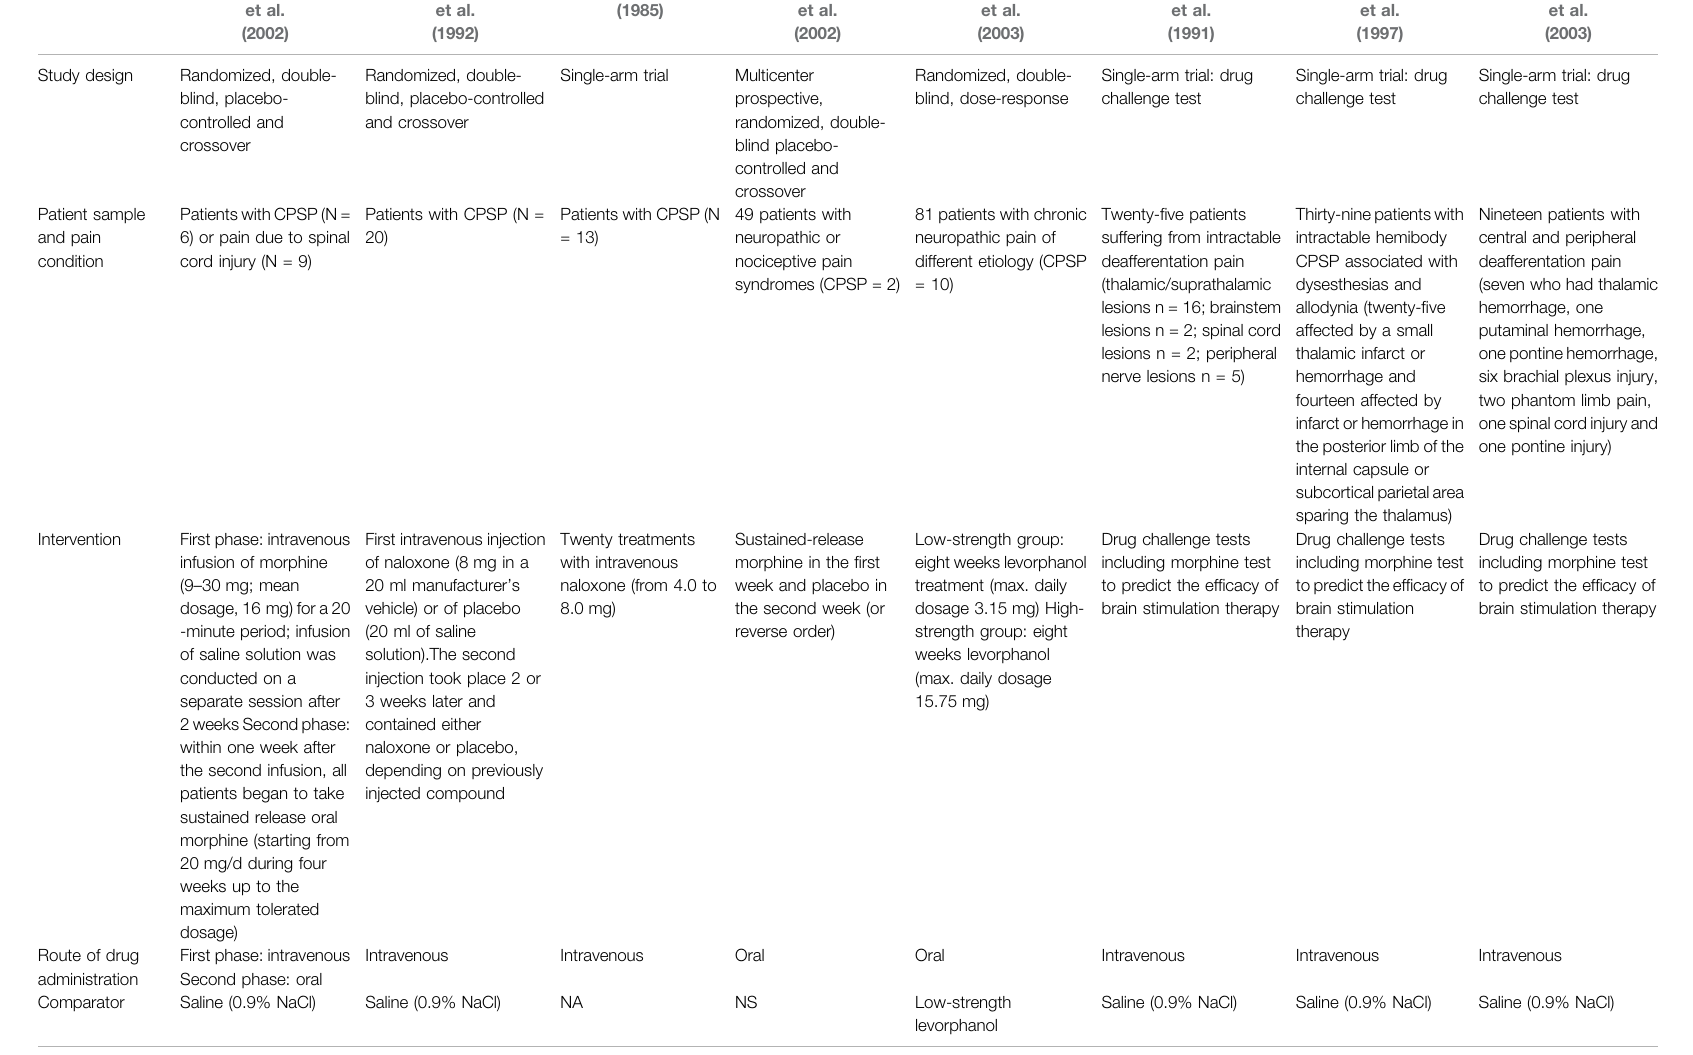
TABLE 1 | Summary of the characteristics of study design of the trials included in qualitative analysis. Study Attal et al.